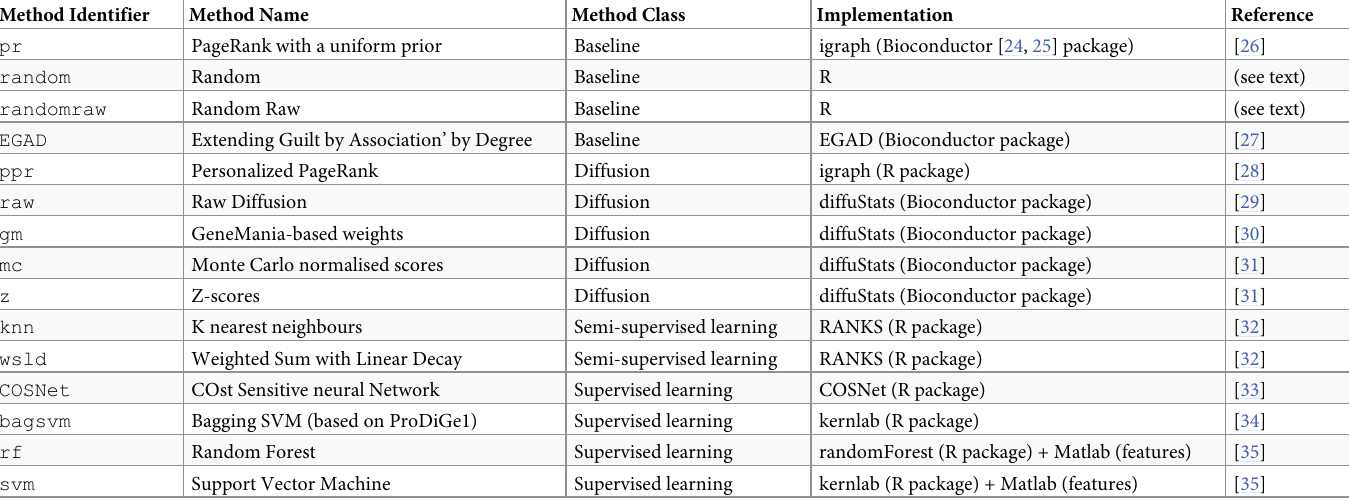
Table 1. List of methods included in this